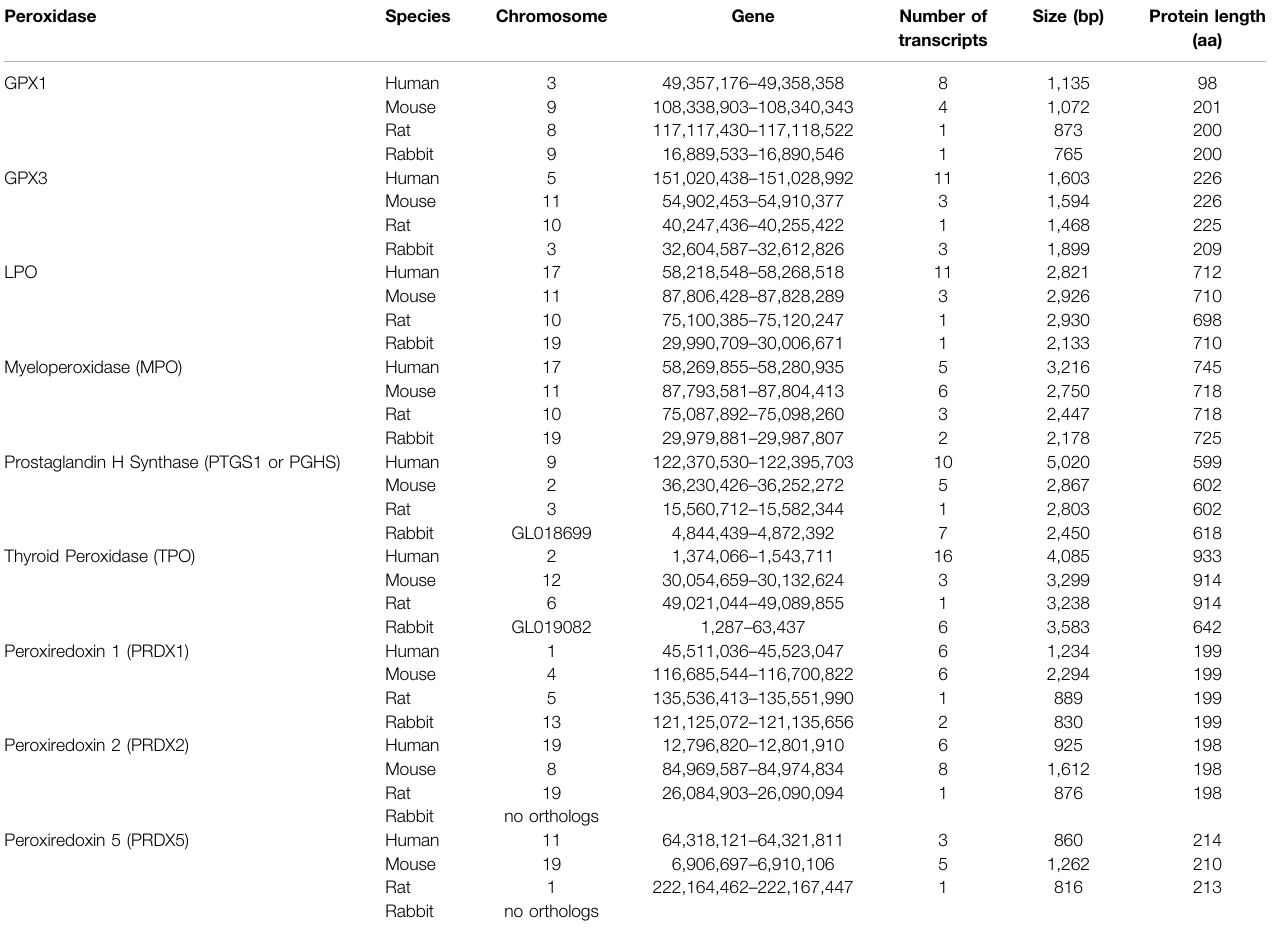
TABLE 1 | Genetic source and comparison of antioxidants and free radical scavengers identi fi ed in the lacrimal gland and ocular surface cells or tear secretion of human, mouse, rabbit or rat (Flicek 2020). Peroxidase Species Chromosome Gene Number of